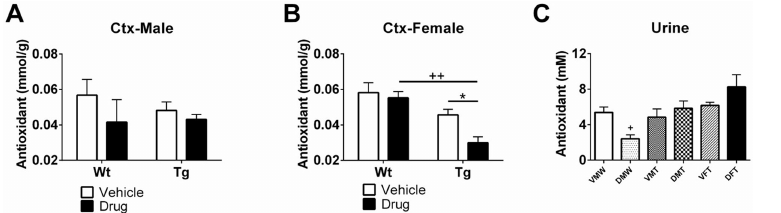
Fig 4. Total antioxidant capacity levels in the cortex of (A) male mice, (B) female mice, and (C) urine samples. VMW: vehicletreated male Wt mice, DMW: drug treated male Wt mice, VMT: vehicletreated male Tg mice, DMT: drug treated male Tg mice, VFT: vehicletreated female Tg mice, DFT: drug treated female Tg mice. Genotype effect (Wt v.s. Tg): +P < 0.05, ++P < 0.01.Treatment effect (vehicle v.s. drug): * P < 0.05.All data are expressedas Mean ± SEM, N = 5 mice/group.